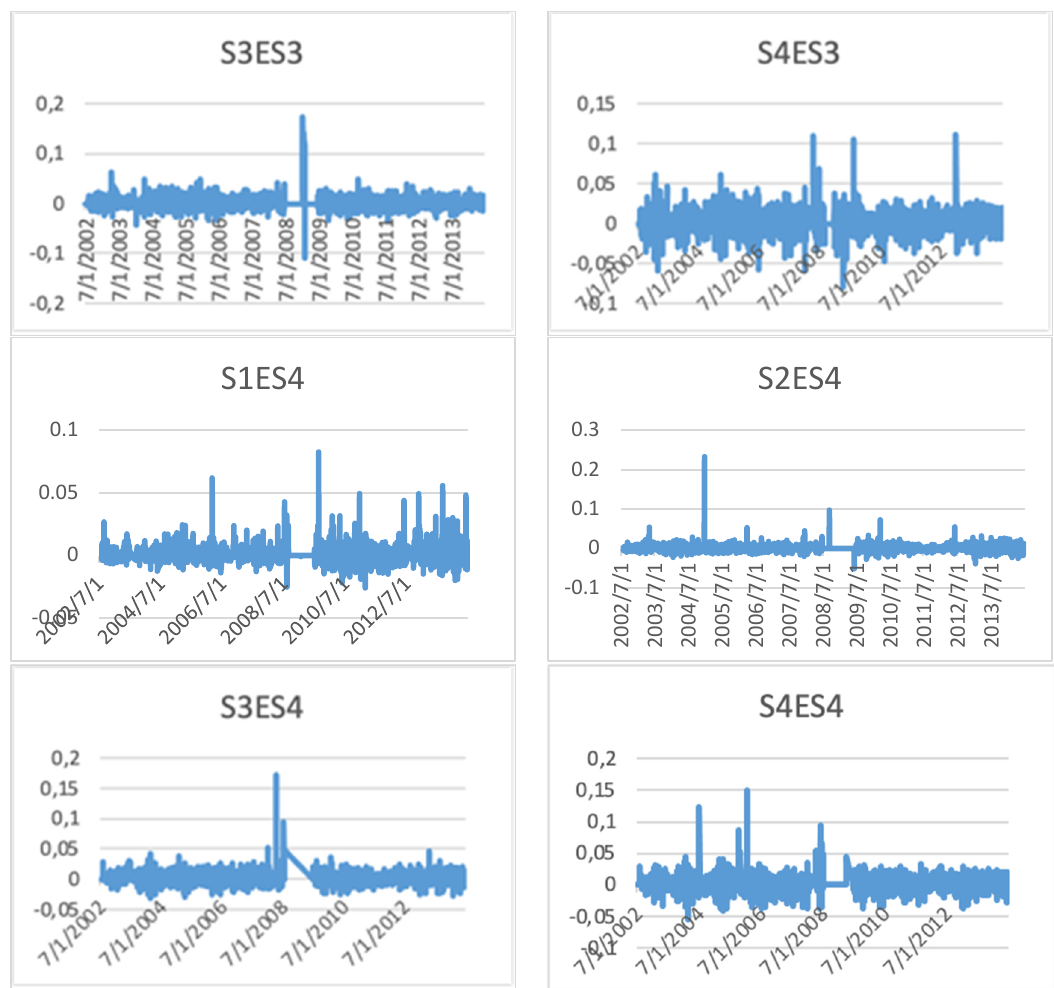
Figure A6. Daily Returns of Size (S) and ES Portfolios (99% Level of Confidence).